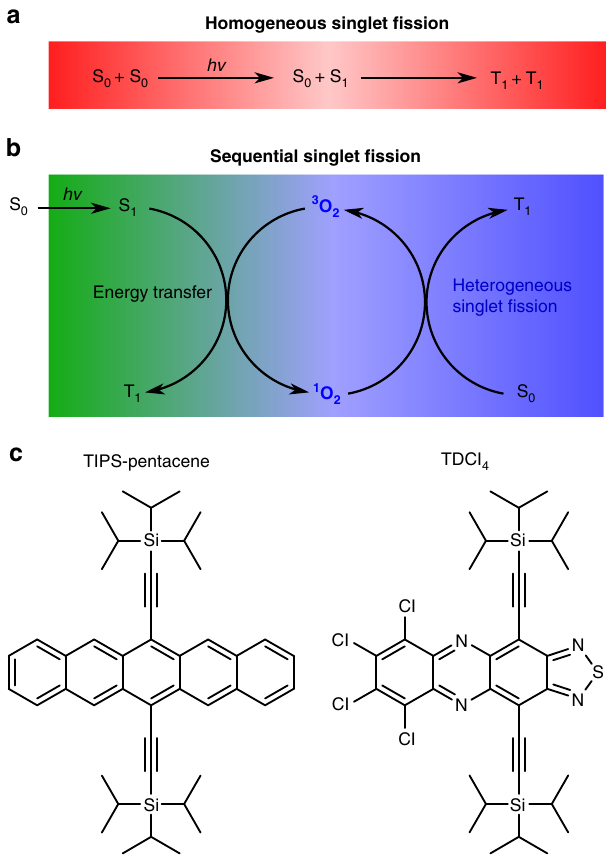
Fig. 1 Overview of reaction mechanisms and molecular structures. a Reaction scheme for homogeneous singlet fi ssion. Upon excitation, a singlet exciton interacts with a ground-state chromophore to yield two triplet states. b Photocycle for oxygen-catalysed sequential singlet fi ssion. The excited singlet chromophore transfers part of its energy to 3 O 2 in